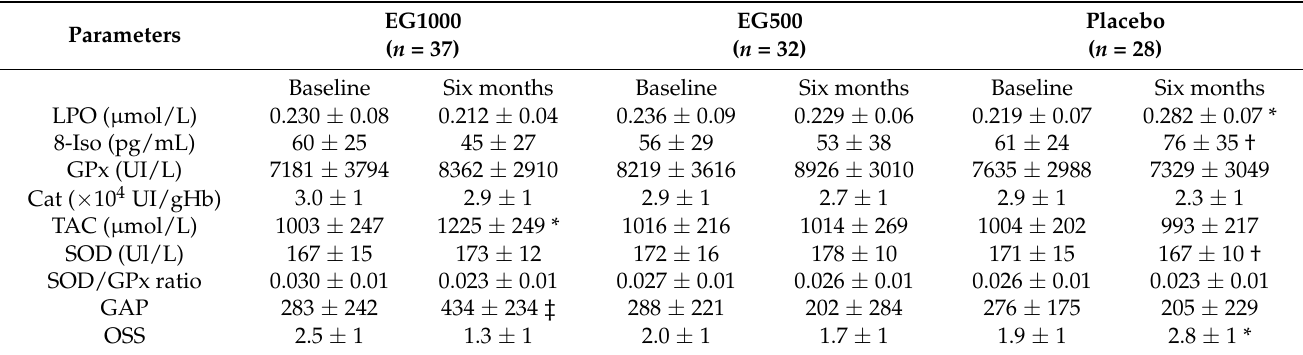
Table 3. OS markers in the study groups: baseline and after six months.